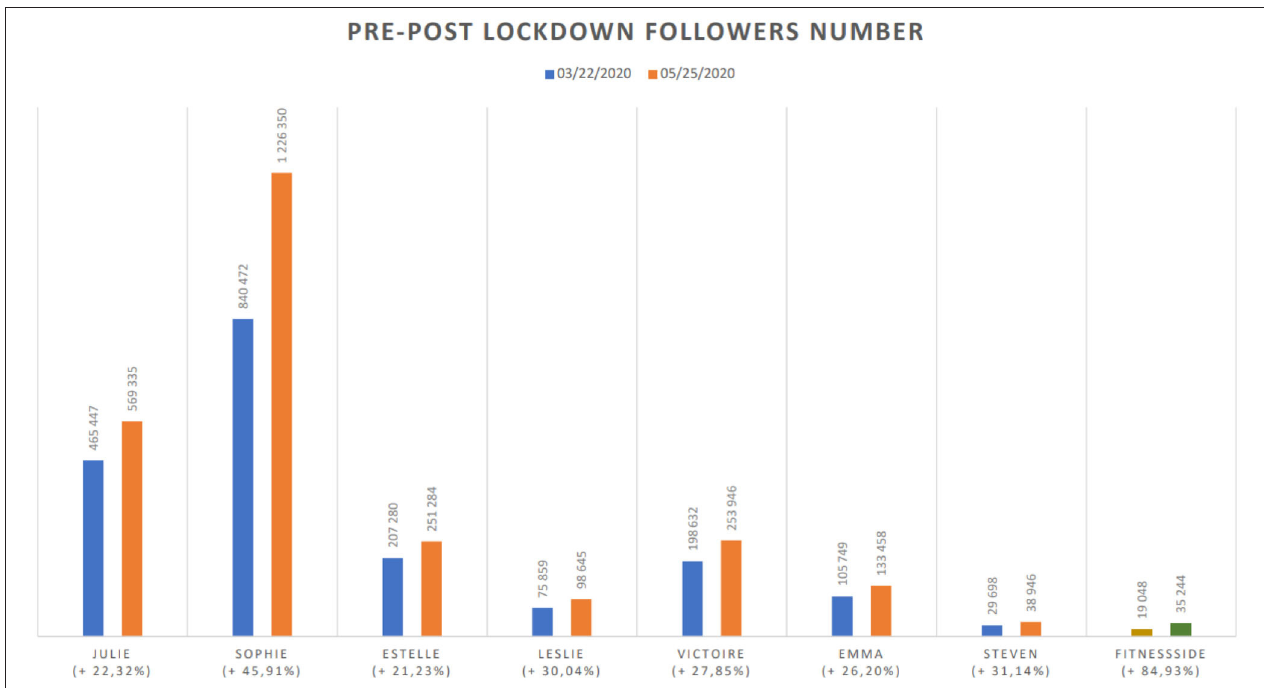
FIGURE 1 | Pre-post lockdown followers